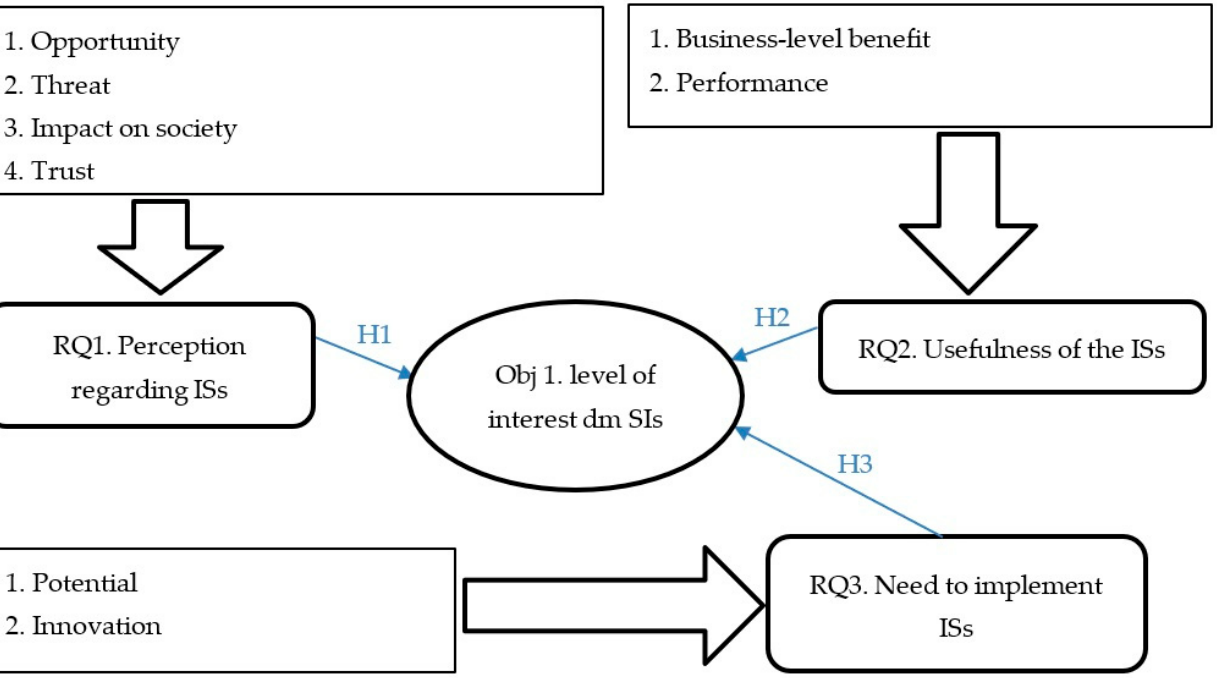
Figure 2. Conceptual model and hypotheses to be tested with SmartPLS 3 (Source: elaborated by the authors). Davenport, 2017 [5,6]; Zhang and Dafoe, 2019 [17]; Fast and Horvitz, 2017 [18];